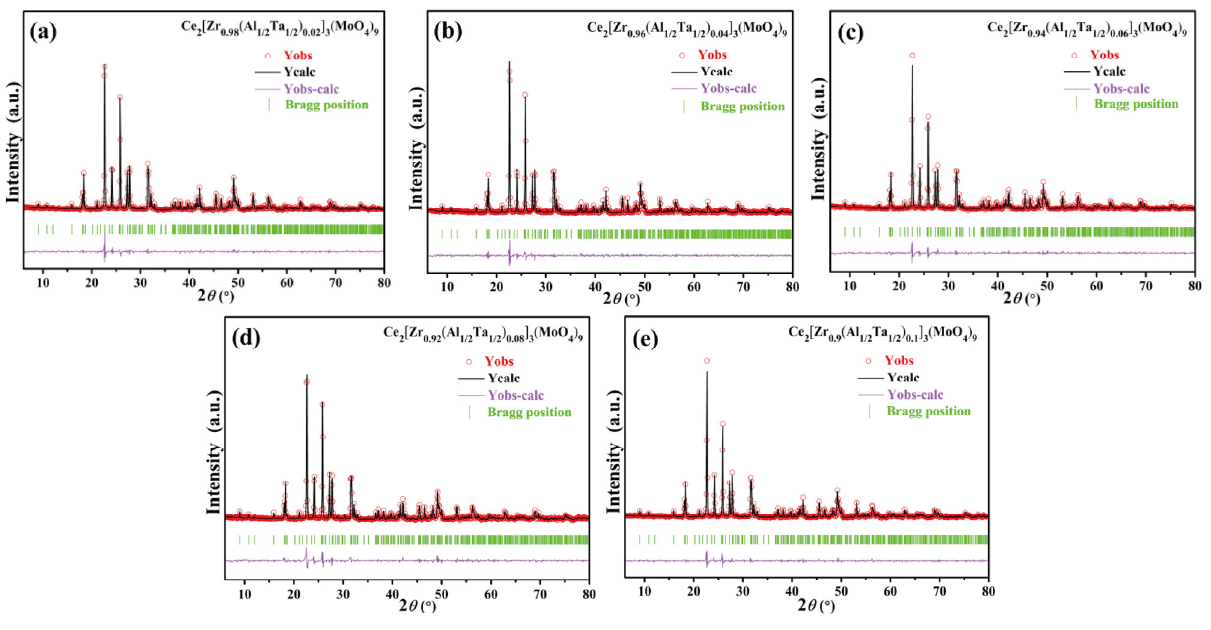
Fig. 2 Rietveld refinement patterns of CZMAT ceramics sintered at 850 ℃